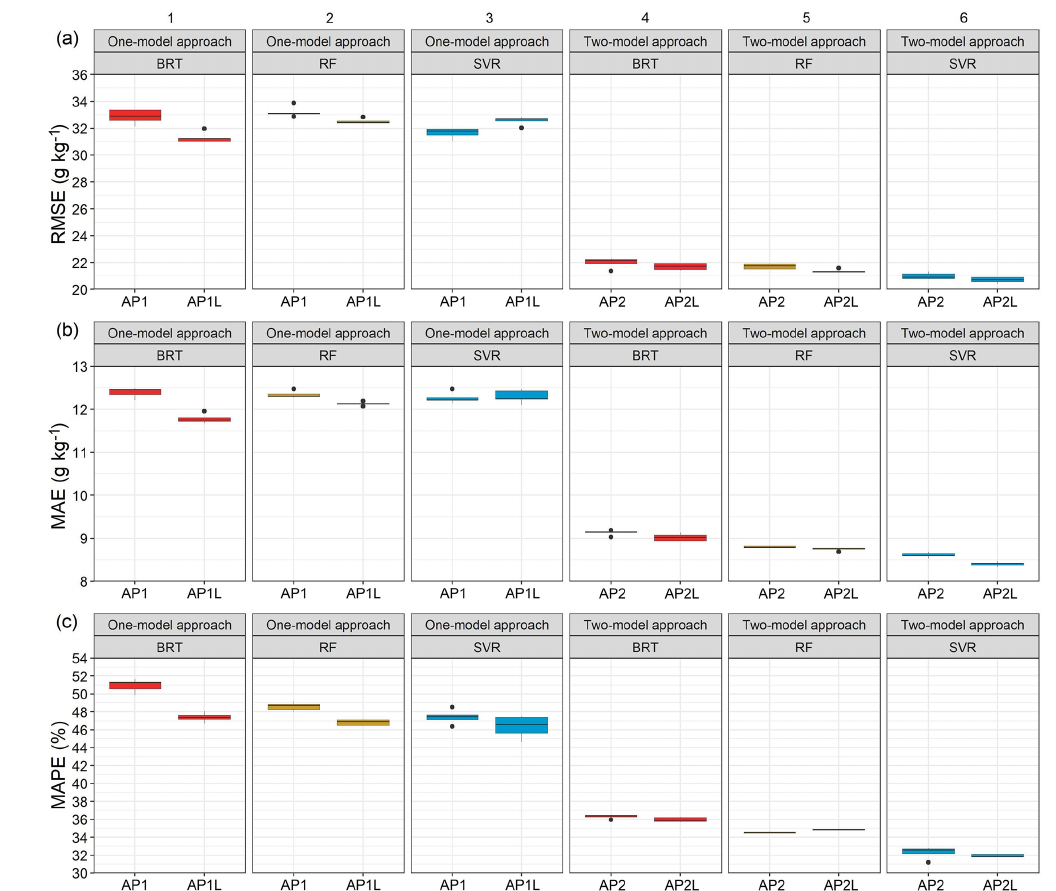
Figure 2. Performance indicators of the three algorithms: the (a) the RMSE (gkg − 1 ), (b) the MAE (gkg − 1 ), and (c) the MAPE (%) for the one-model approach (without LUCAS data, AP1, and with LUCAS data, AP1L) versus the two-model approach (AP2 and AP2L). The whiskers of the boxplots show 1.5 times the interquartile range. Please note that the y axis is shortened for better visibility and does not display a zero. The abbreviations used in the figure are as follows: BRT – boosted regression trees, RF – random forest, and SVR – support vector